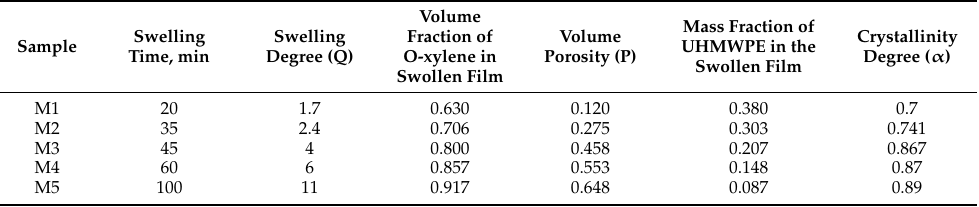
Table 2. Some parameters of the membrane preparation process: porosity and crystallinity degree of the obtained